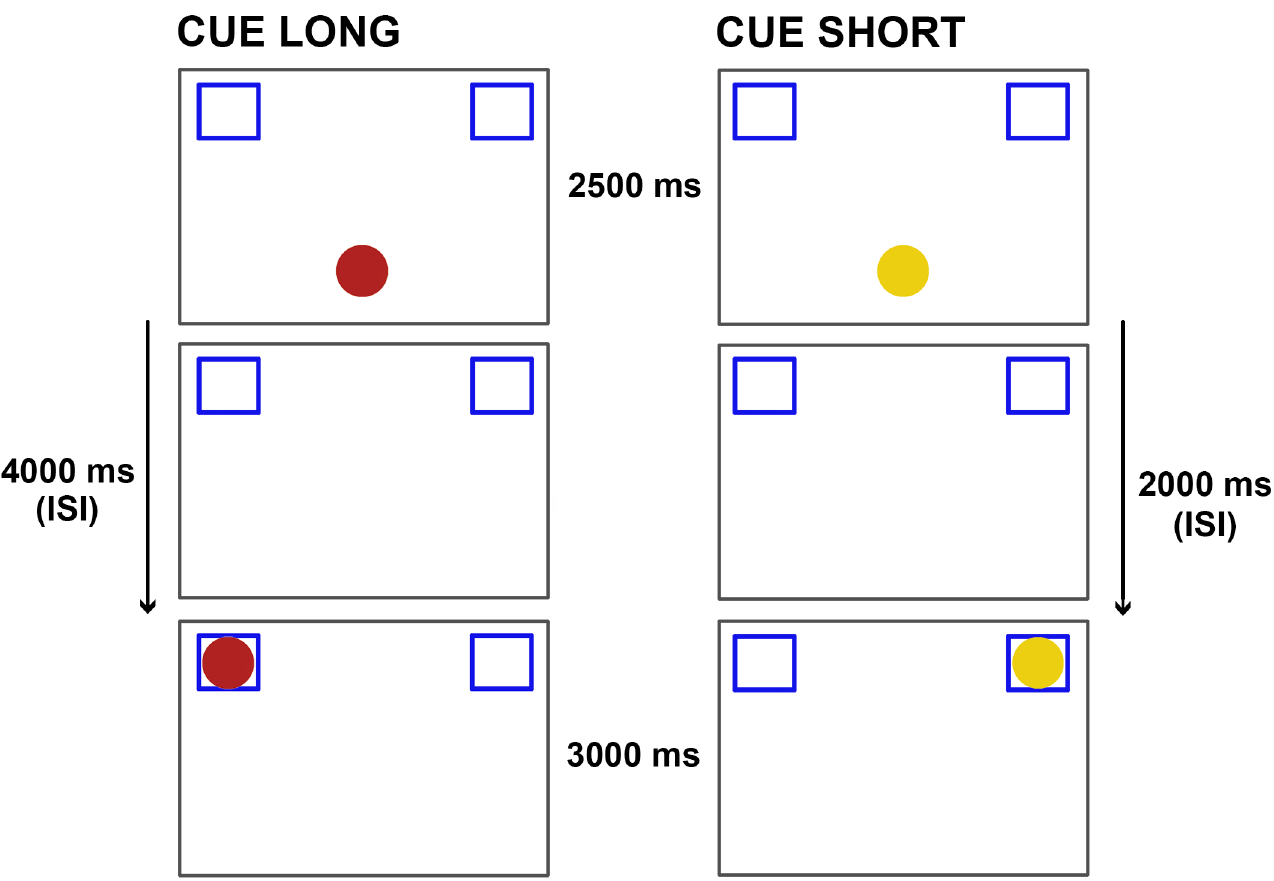
Fig 1. Experimental design. The cueing stimuli providedsimultaneous predictive information regardingspatial location(right or left side) and temporalcue-to-target delay (short/long). Space and time was counterbalanced betweenparticipants, such that half of the participants watched the pairingleft-short/right-longwhilethe other half watched left-long / right-short. Cues were Elmo and Big Bird cartoons (here represented with a red and yellow circle respectively for illustrative purposes due to copyrightrestriction).